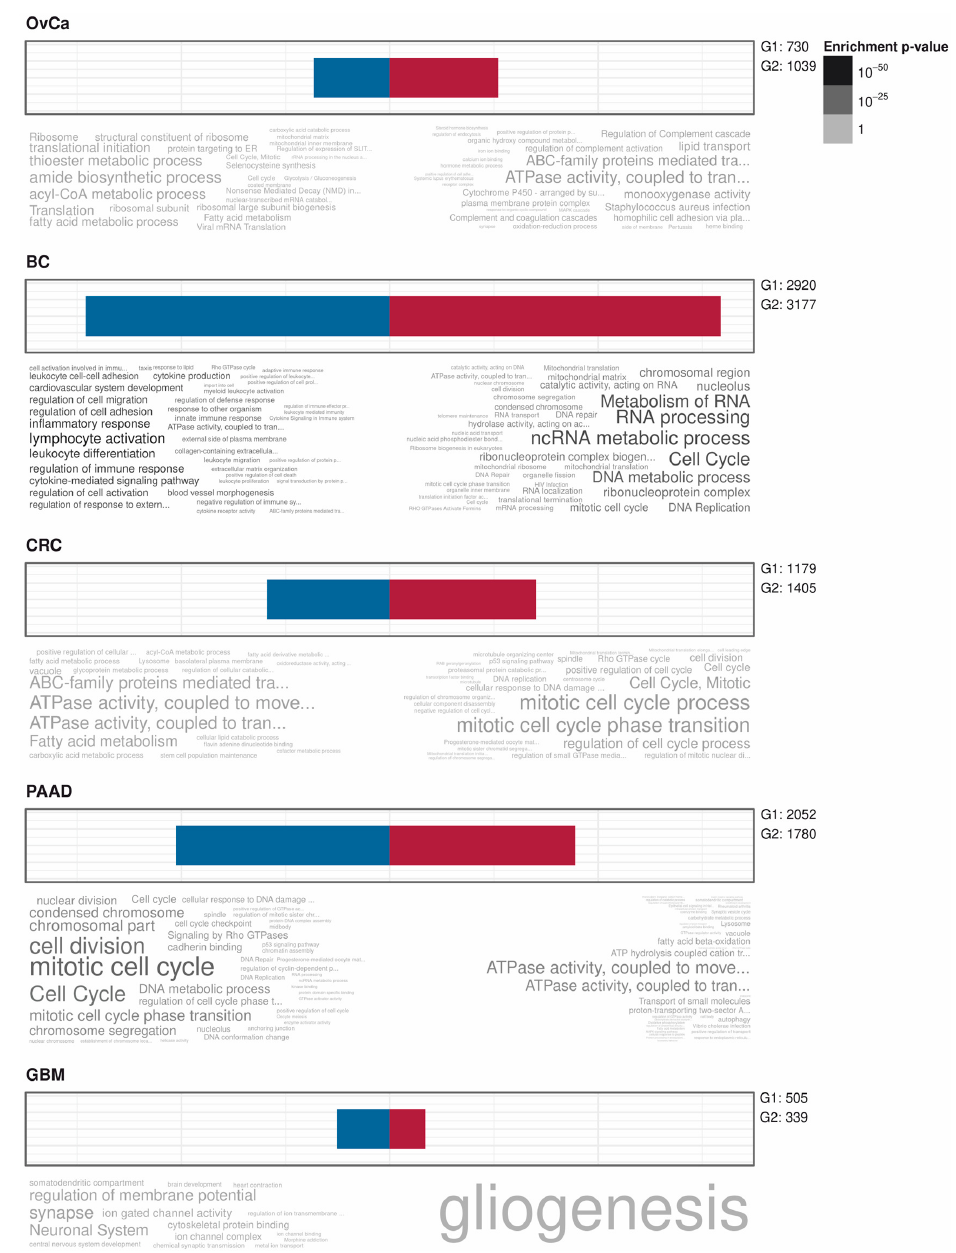
Figure 6. Enrichment plots of gene ontology terms and pathways of negatively (blue; G1) and (red; G2) with the MDF / MUMF correlated genes in di ff erent cancer entities are shown. For OvCa and positively (red; G2) with the MDF/MUMF correlated genes in different cancer entities are shown. For OvCa and GBM a 10% FDR cutoff, for all other cancer entities a 5% cutoff was used. Enrichments are GBM a 10% FDR cuto ff , for all other cancer entities a 5% cuto ff was used. Enrichments are indicated in indicated in word clouds by size and color (p-values). Overlaps of gene lists are shown in Figure S15. word clouds by size and color ( p -values). Overlaps of gene lists are shown in Figure